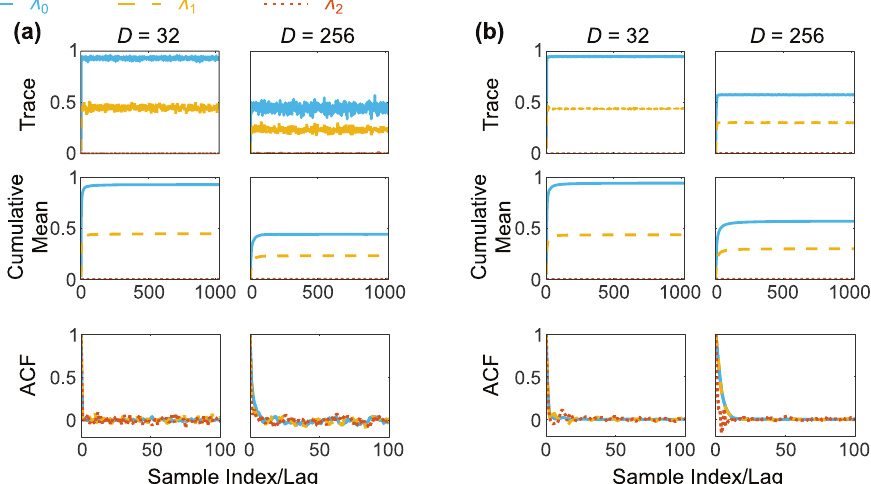
Fig. 7 Example MCMC chains. a Full likelihood of Eq. (3). b Pseudo-likelihood of Eq. (9). The three metrics of interest are plotted separately for each observable λ n . The chains in a are examples from Fig. 1 of the main text, and those in b from Fig.